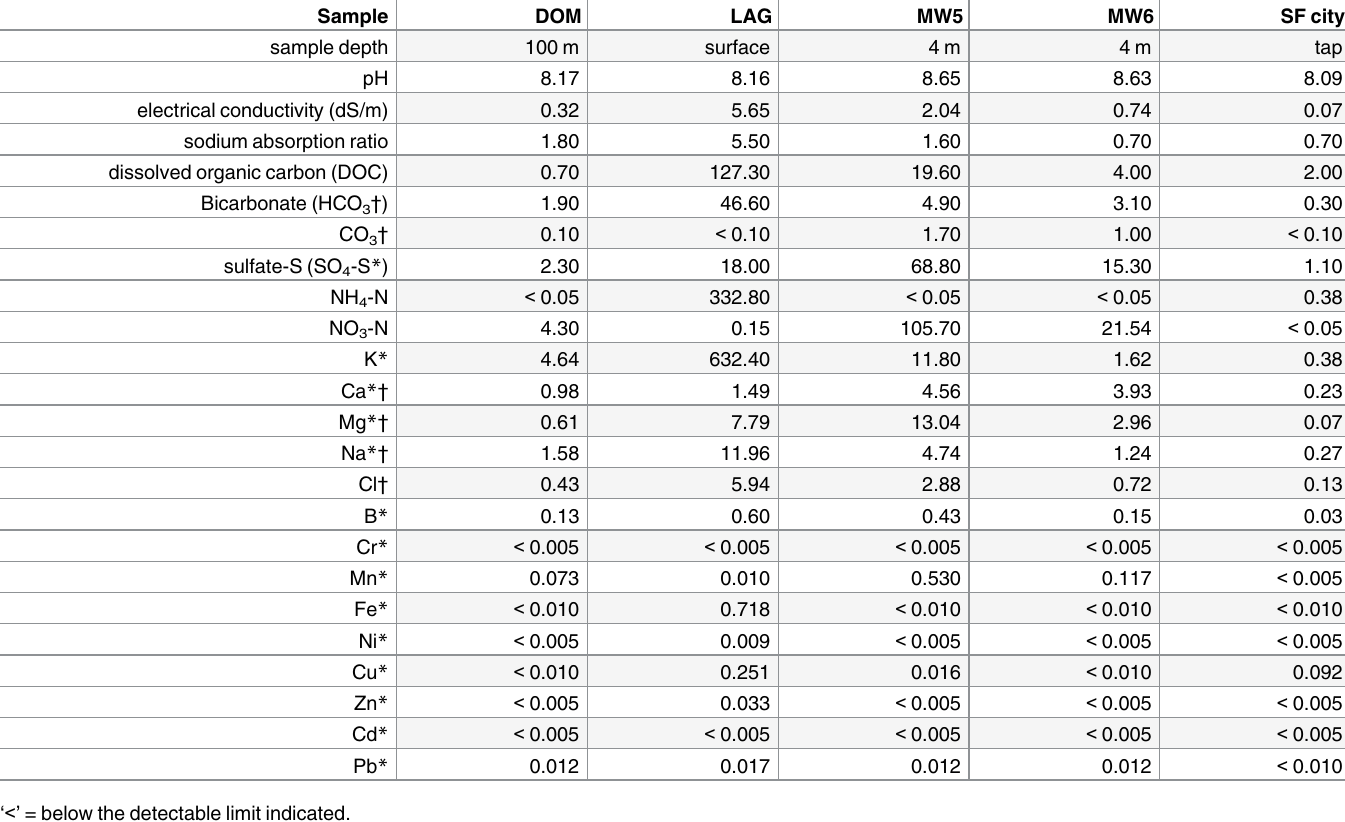
Table 1. Water ion analysis. Concentration of solublemetals, ions, nitrogen, sulfur, and organic compounds in the water samples (parts per